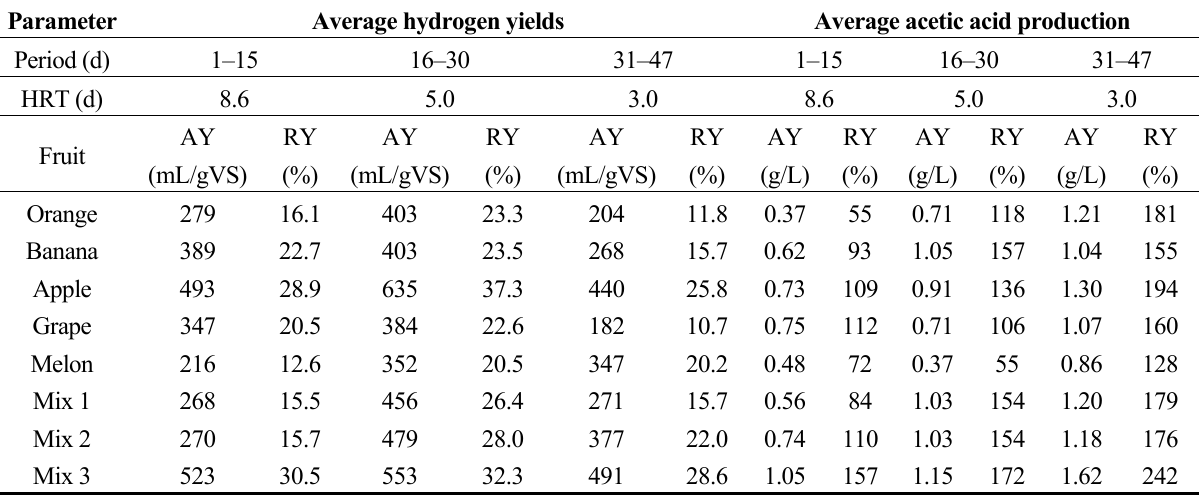
Table 2. Comparison of hydrogen yields and acetic acid production with theoretical values.